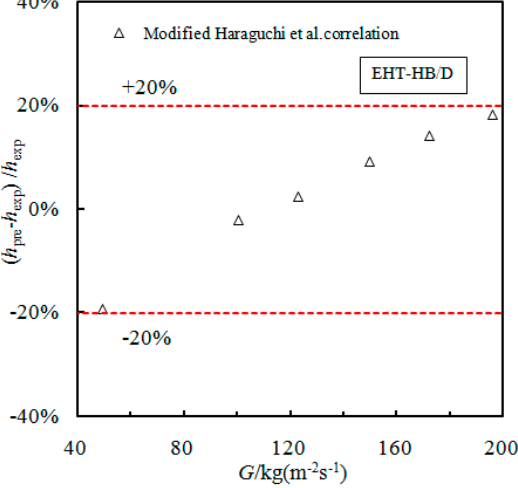
Figure 7. Comparison of the modified Haraguchi et al. correlation for use with the EHT-HB/D tube. Table 2. Modified Haraguchi et al. correlation.